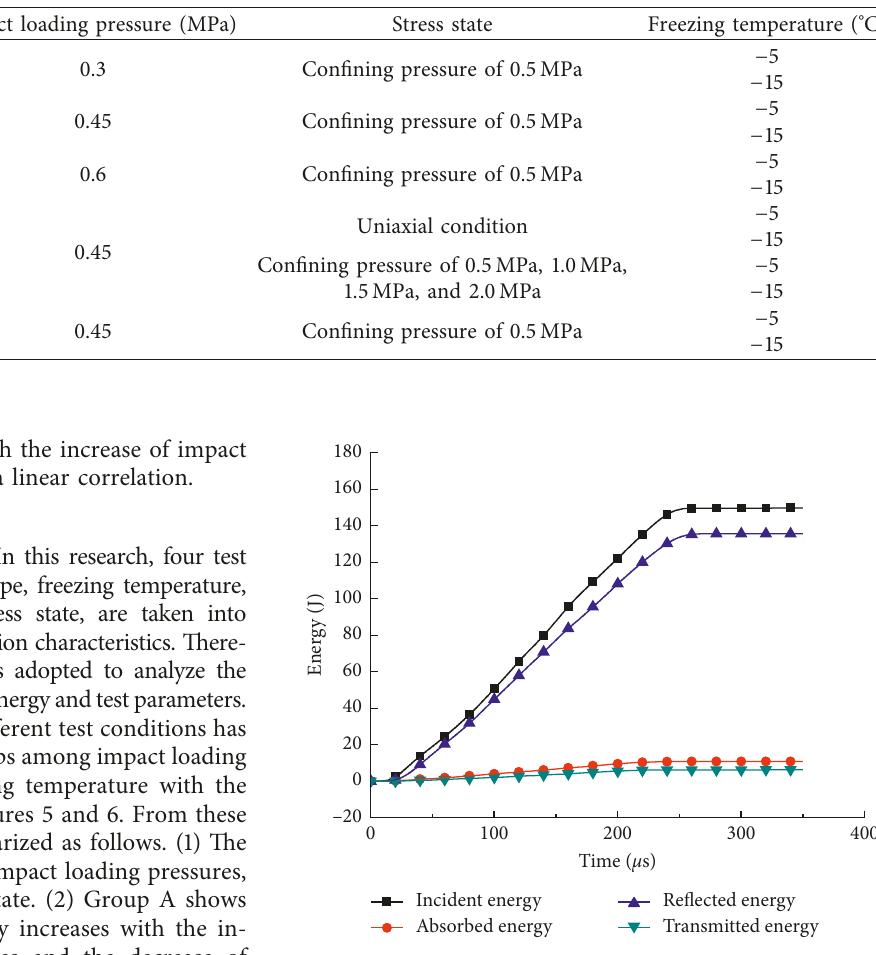
Figure 3: Energy-time curve of sandy soil (Group B) at a confining pressure of